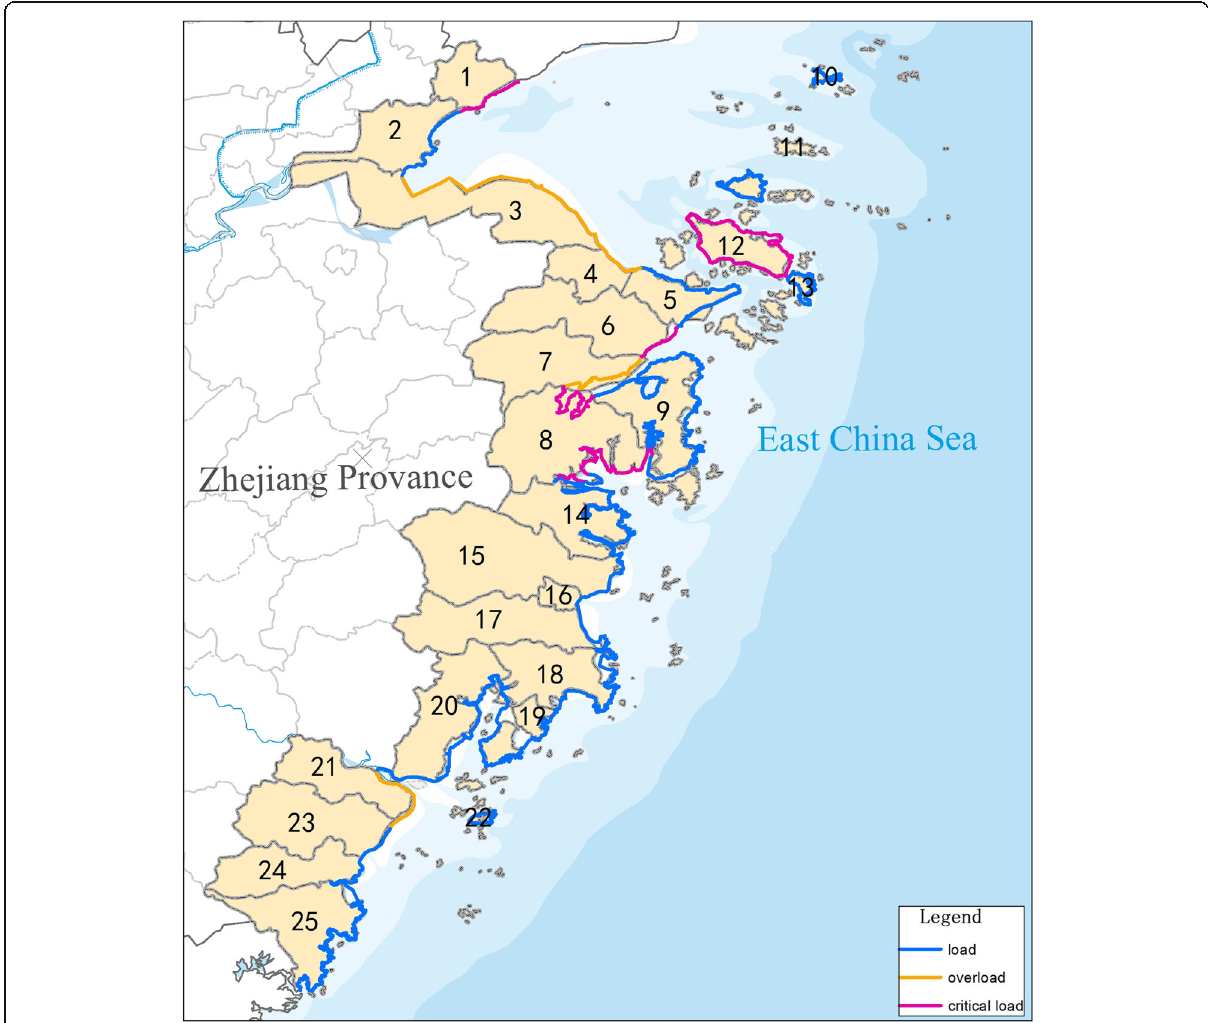
Fig. 5 The carrying capacity grades of the coastline in Zhejiang